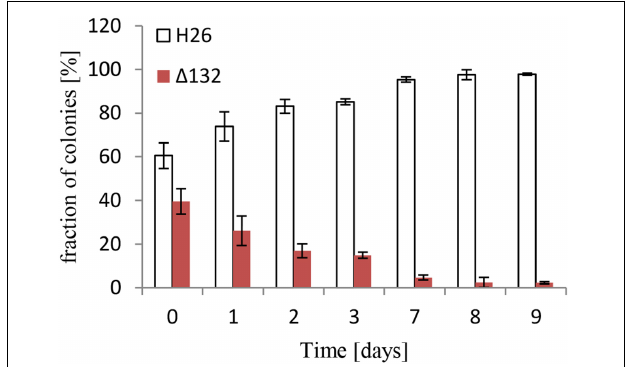
FIGURE 3 | Transcript levels of sRNA132 and the HVO_A0477-A0480 operon mRNA at different phosphate concentrations. The operon encodes a phosphate-specific ABC transporter. The wild-type H26 and the sRNA132 gene deletion mutant were grown in media with various phosphate concentrations, as indicated at the top. At mid exponential growth phase (about 5 × 10 8 cells ml − 1 ) aliquots were removed, RNA was isolated and used for Northern blot analyses with operon-specific and sRNA-specific probes, as indicated at the right. Ethidium bromide stained 23S and 16S rRNAs are shown at the bottom. The two red boxes highlight phosphate concentrations at which the operon mRNA was found only in the presence of the